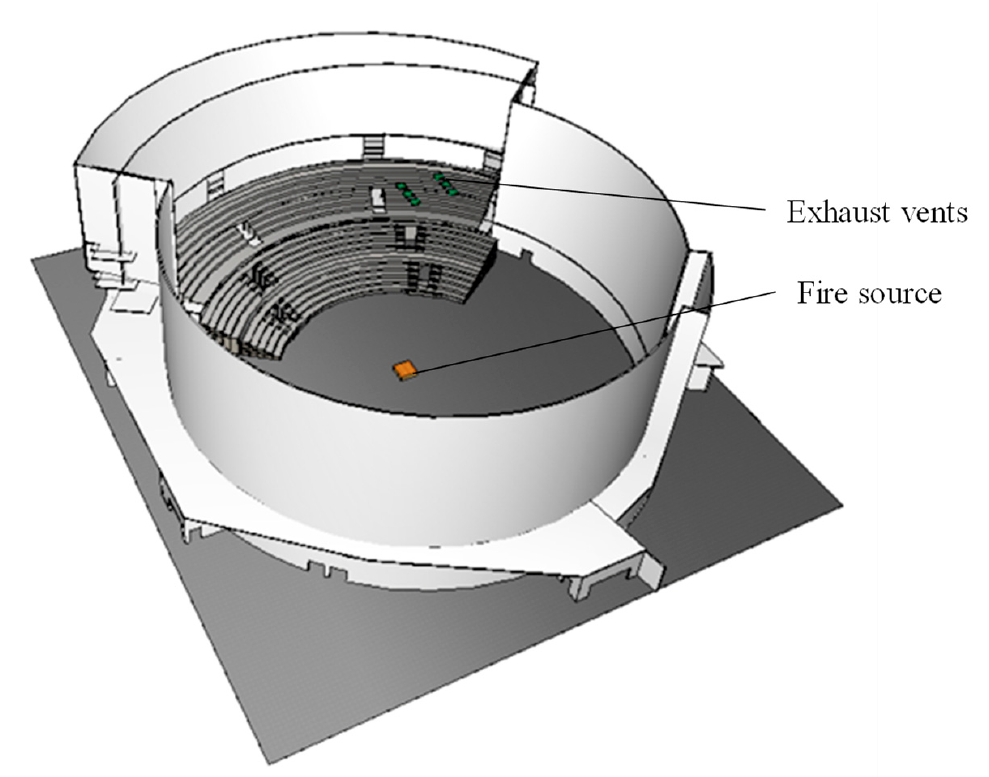
Figure 12. The theater model.